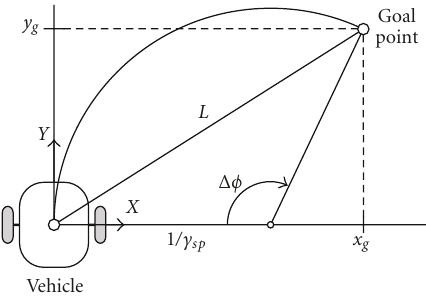
Figure 1: The pure-pursuit strategy.